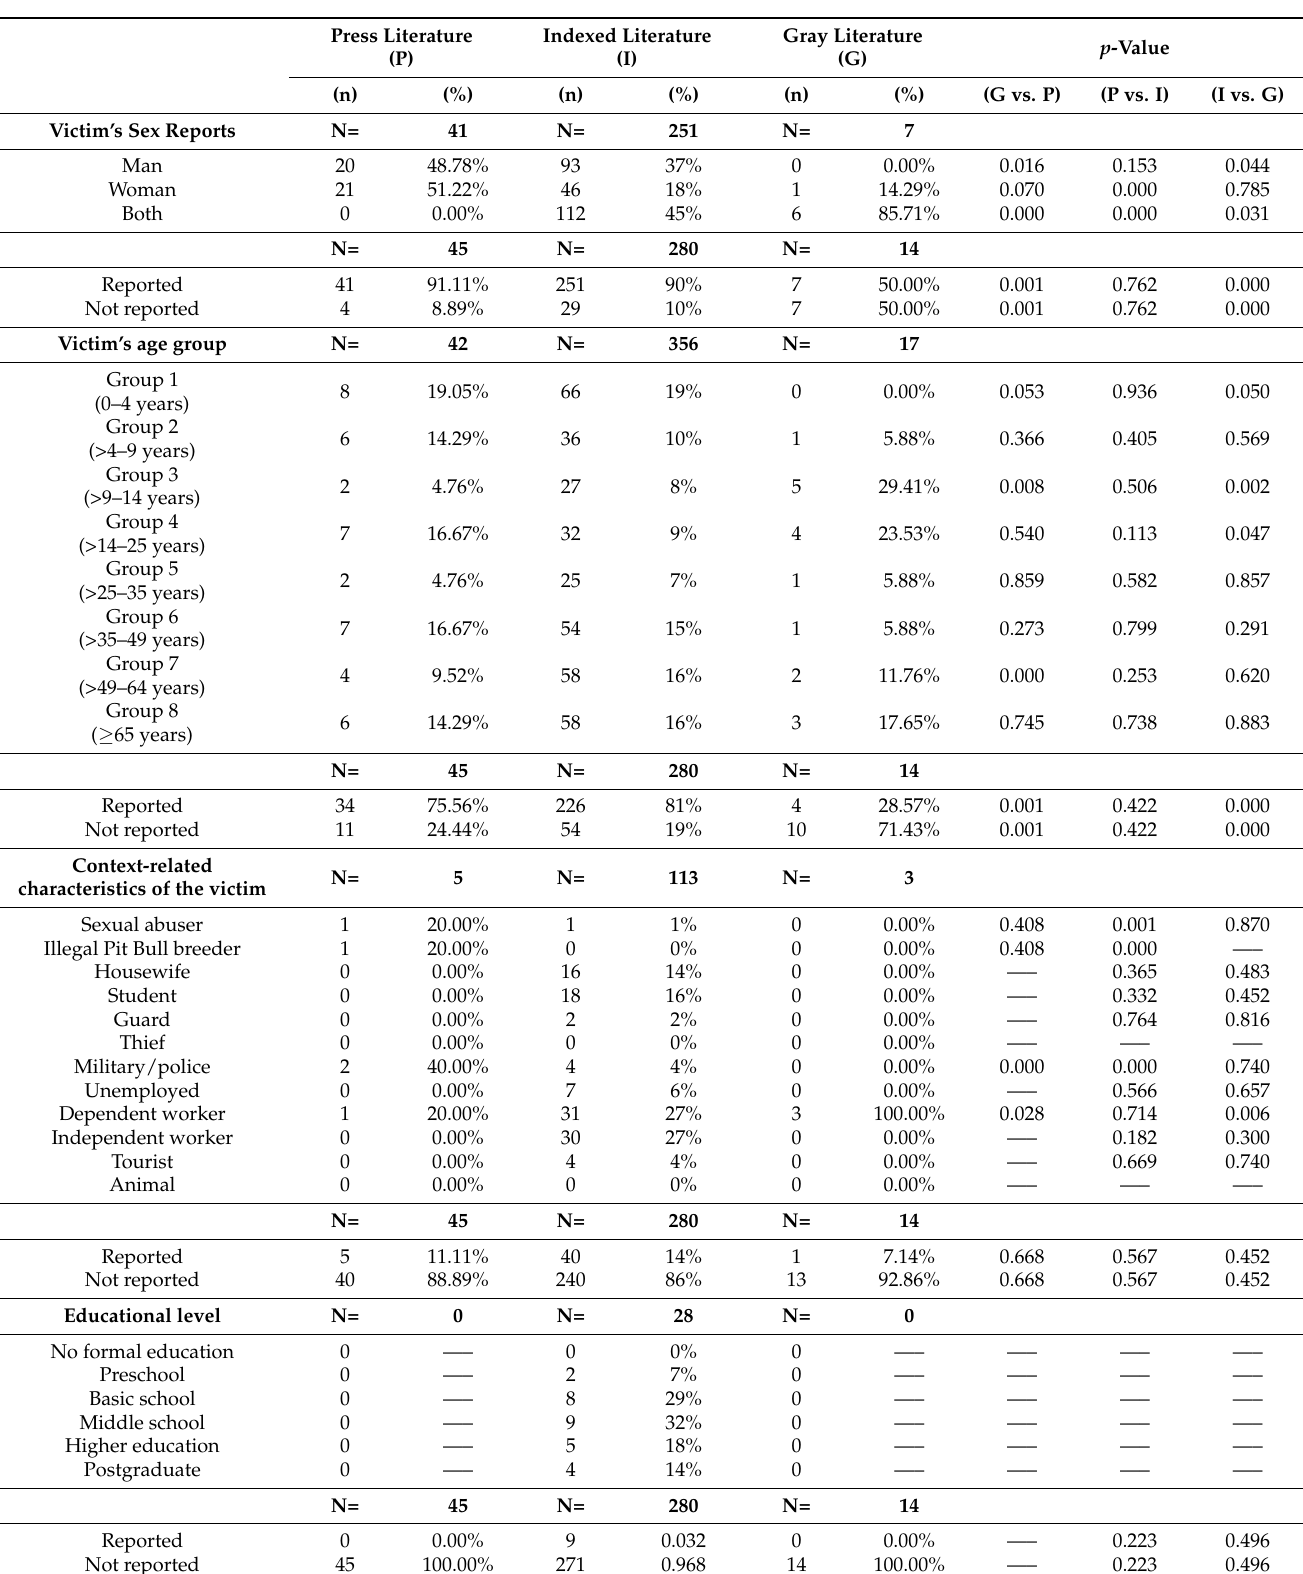
Table 5. Frequency of records that contain information about the person bitten in incidents of canine attacks in the Spanish written press, indexed and gray